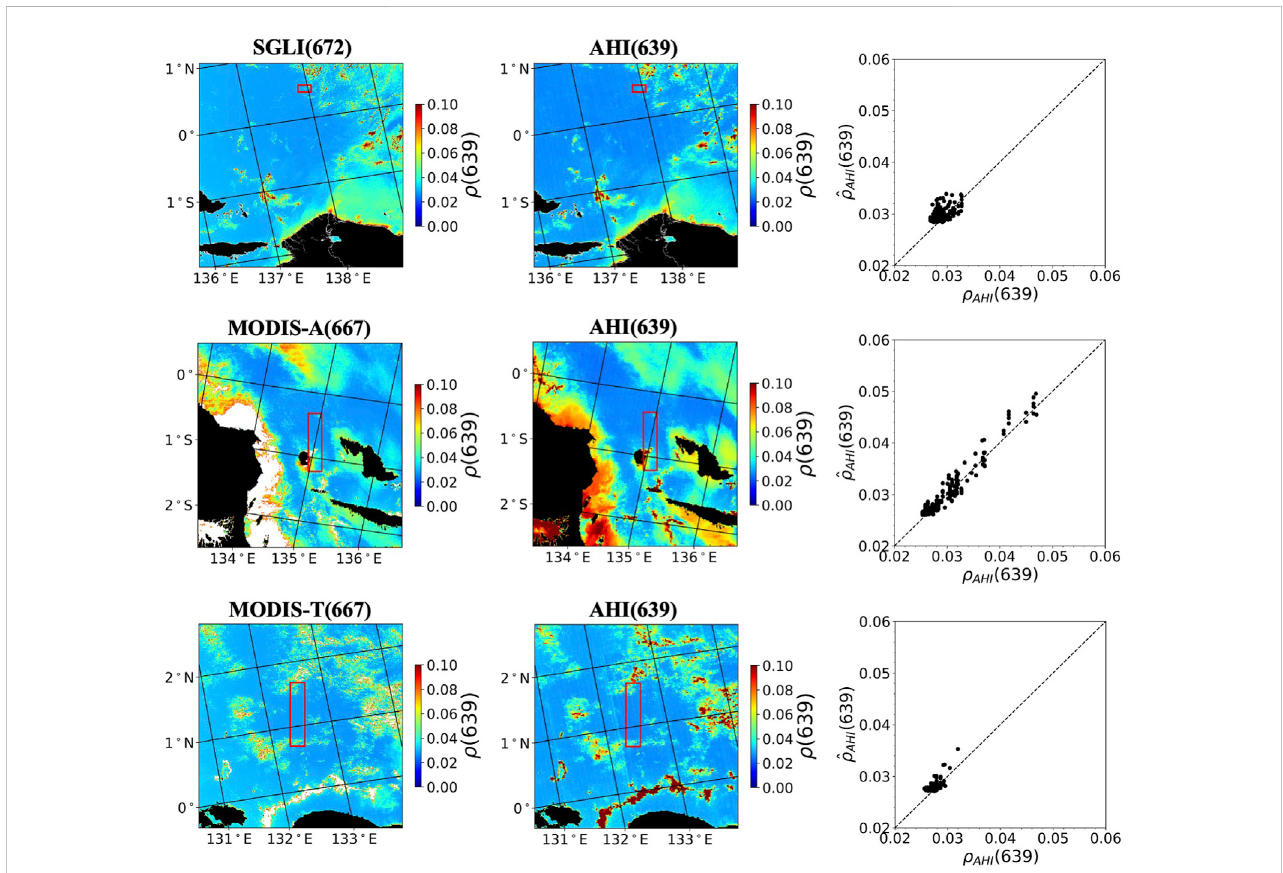
FIGURE 3 Same as Figure 2, but for AHI 639 nm. The equivalent AHI re fl ectance at 639 nm is obtained from SGLI re fl ectance at 672 nm and MODIS re fl ectance at 667 nm (see Table 2 for the conversion coef fi cients).